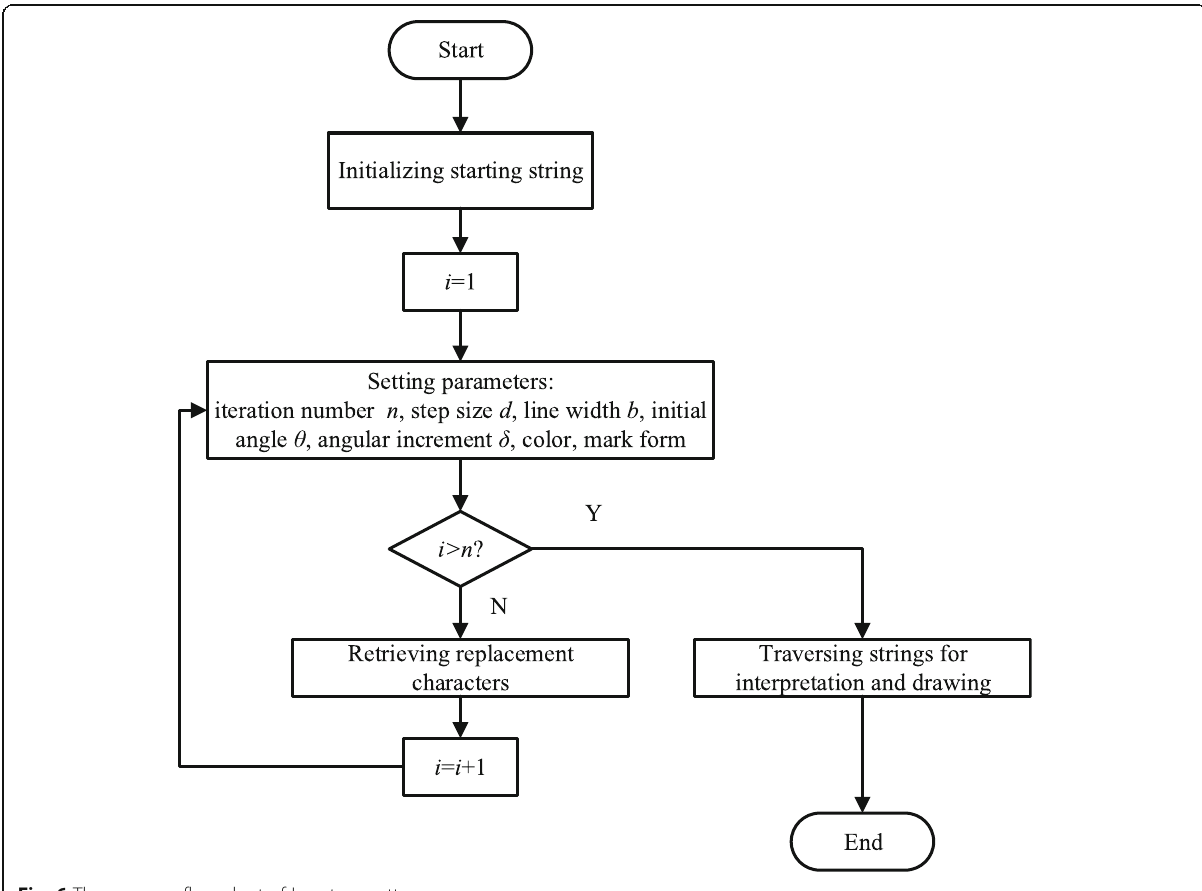
Fig. 6 The program flow chart of L-system